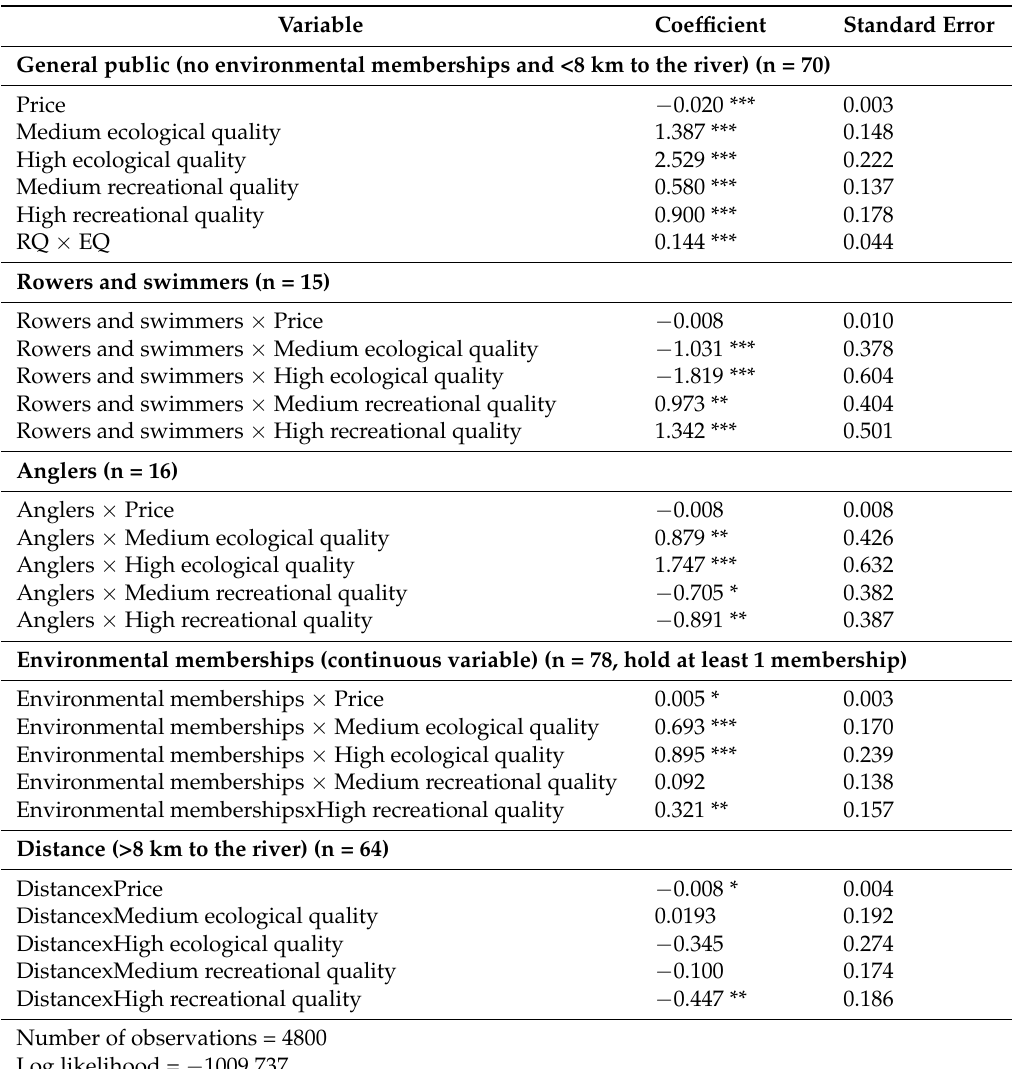
Table 2. Conditional logit model of water quality